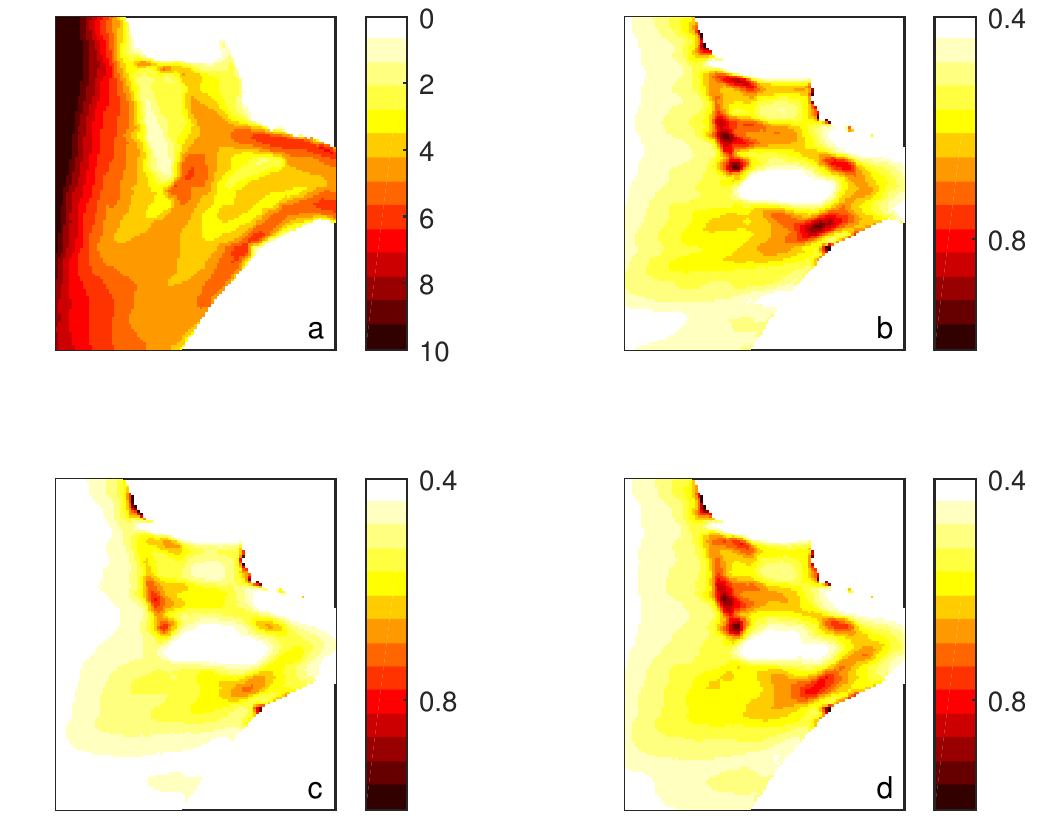
Figure 11. Spatial distribution of ( a ) water depth (m) around the shoal Hinderplaat and wave height (m) obtained with scheme ( b ) FDM-flux, ( c ) FVM-trad, and ( d ) FVM-Roe. The water depth in the same area is also provided for a proper interpretation (panel